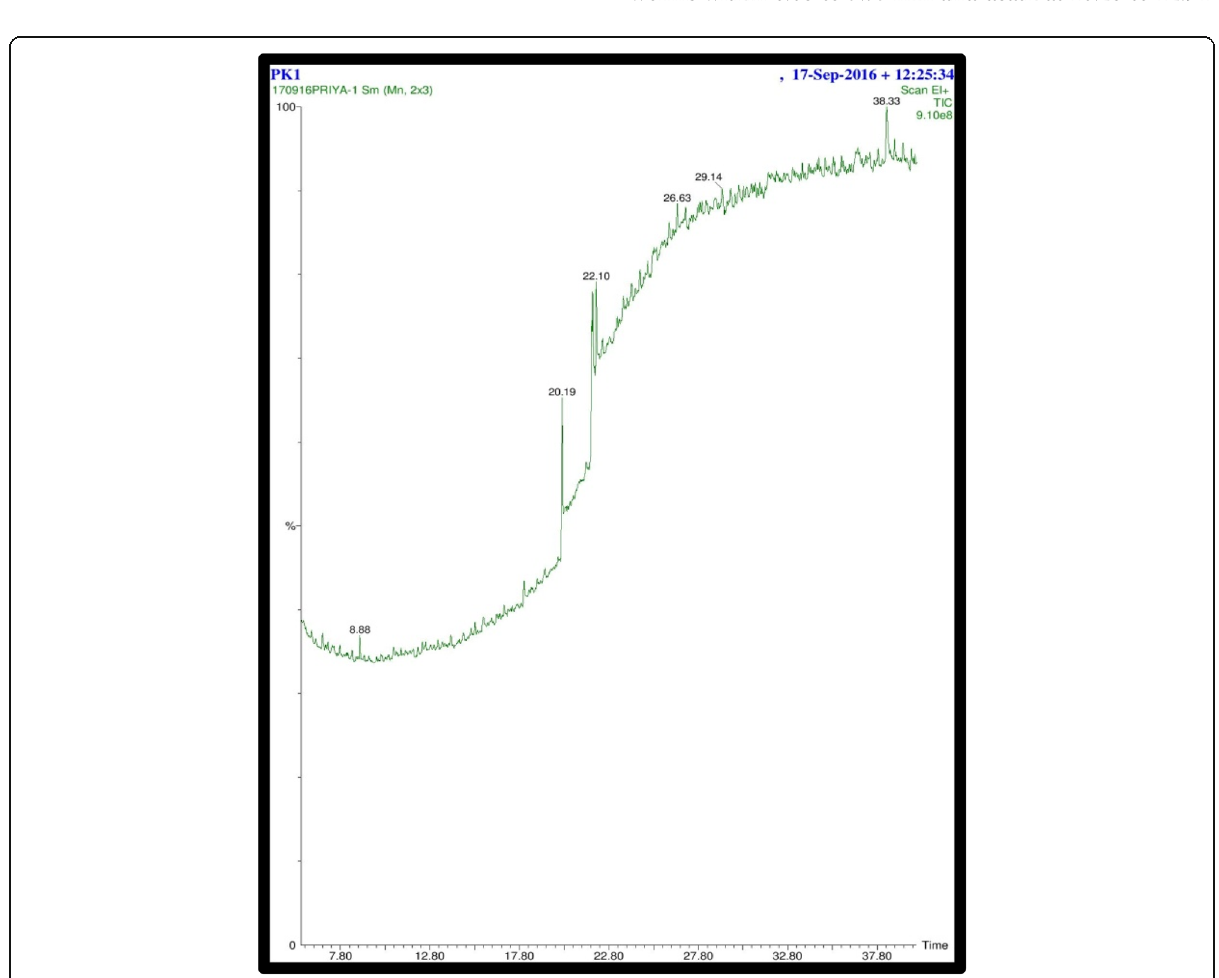
Fig. 4 GC – MS analysis of ethyl acetate extract of C. epigaeus tuber chromatogram (Scan EI+ TIC